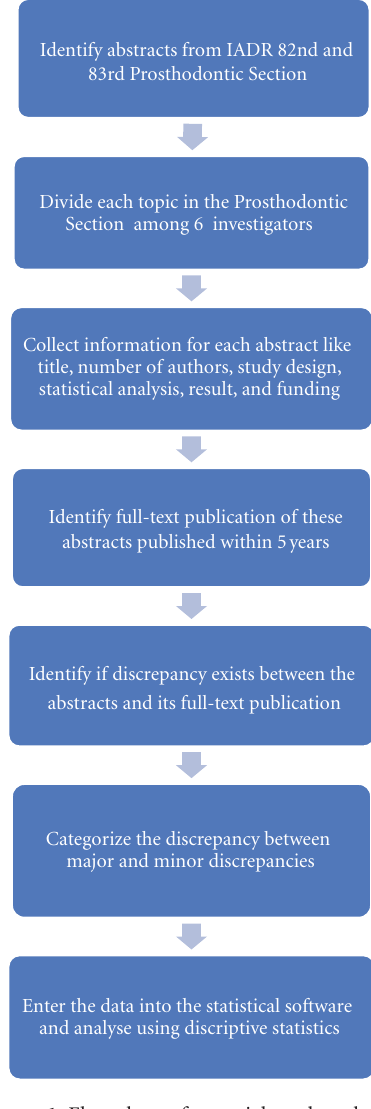
Figure 1: Flow chart of materials and